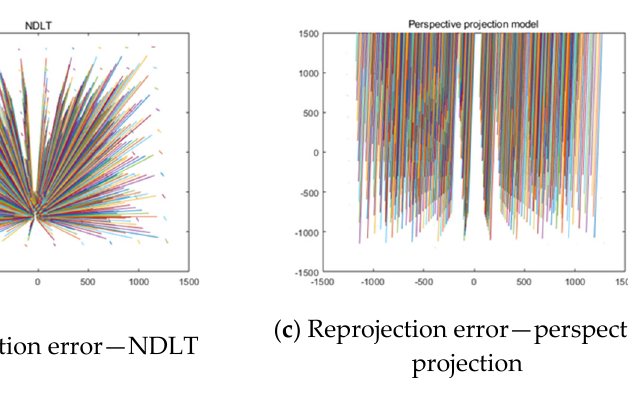
Figure 10. Reprojection error when using GCPs on one plane. Table 3. Estimated camera EOP errors and mean reprojection